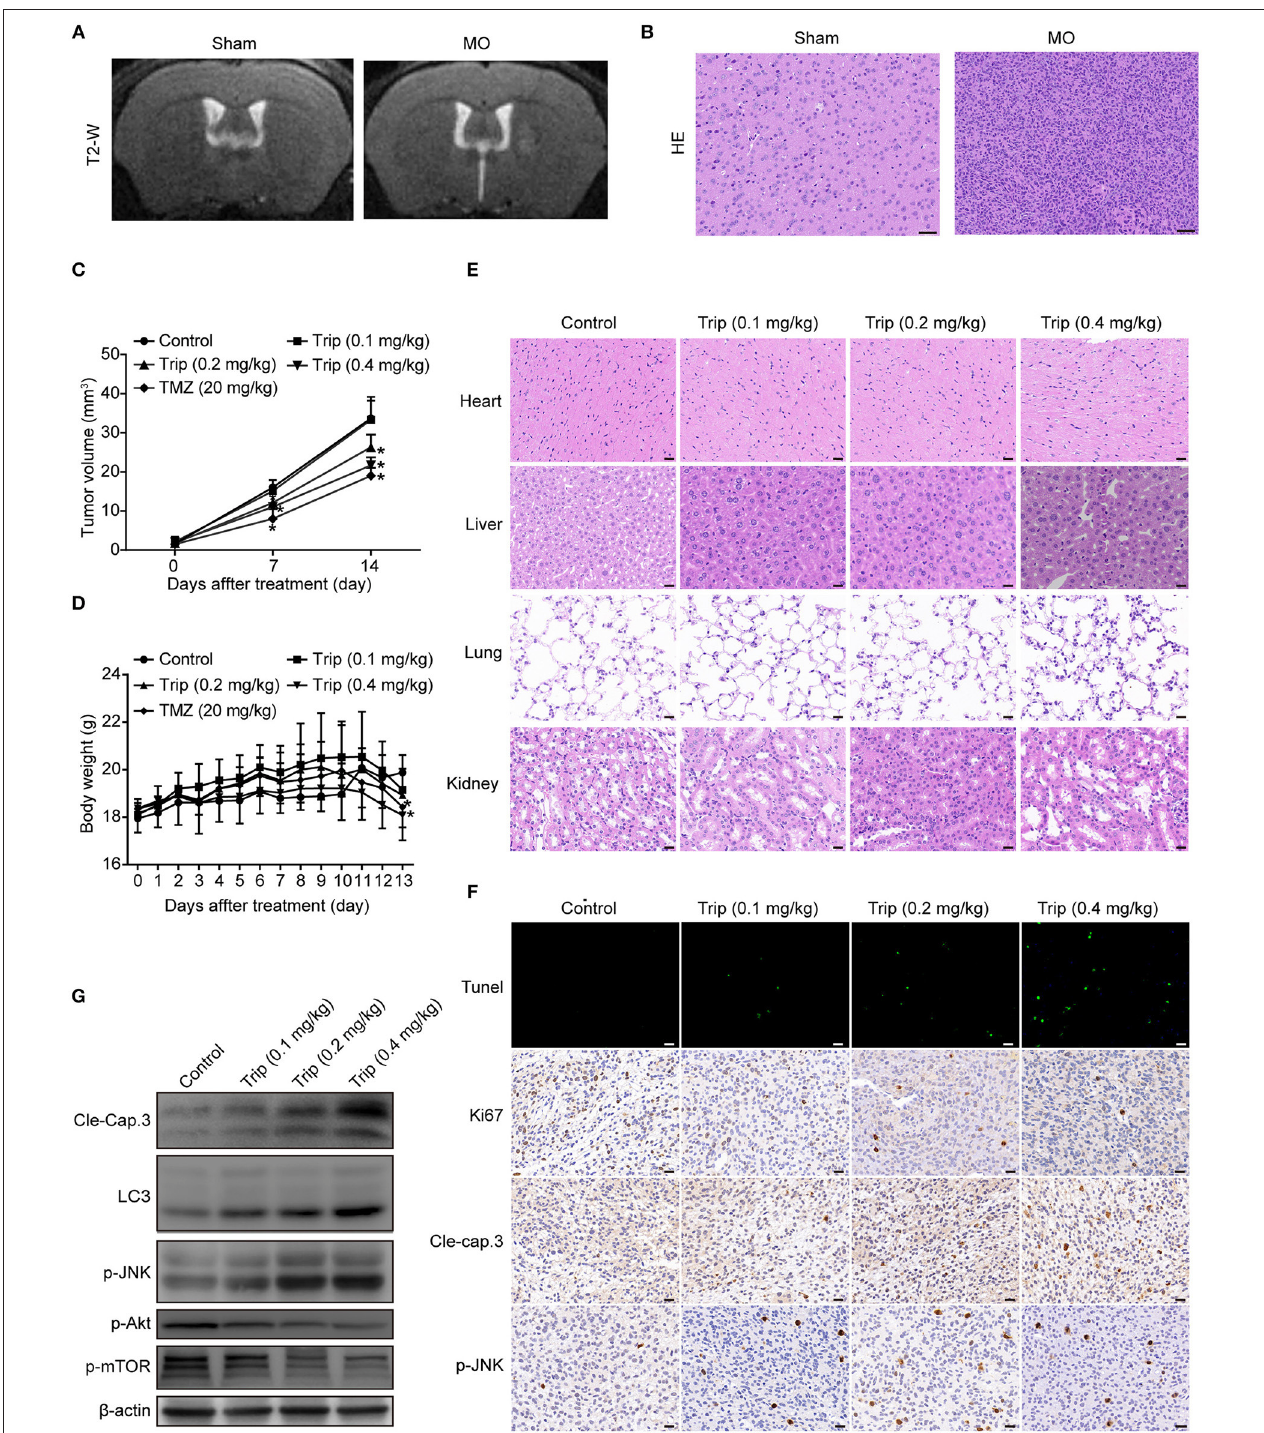
FIGURE 7 | Triptolide inhibited tumor growth in a U251 orthotopic xenograft model. (A) One week after inoculation, T2-weighted MRI images of gliomas were obtained with a 7.0T MRI scanner. (B) H&E staining of gliomas in sham and model mice. Scale bars = 50 µ m. (C) Tumor volumes were determined by MRI at 0, 7, and 14 days after treatment in the vehicle control mice, triptolide-treated mice and TMZ-treated mice. The bars represent the means ± SD. (D) Body weight changes in mice during 13 days of exposure. The bars represent the means ± SD. (E) H&E staining of important organs in the vehicle control mice and triptolide-treated mice. Scale bars = 20 µ m. (F) TUNEL measurement of apoptosis and immunohistochemical staining of tumor specimens. Scale bars = 20 µ m. (G) Western blot quantification of cleaved caspase-3, LC3B, phospho-JNK, phospho-Akt, and phospho-mTOR expression. * P < 0.05, significantly different compared with the vehicle control group.